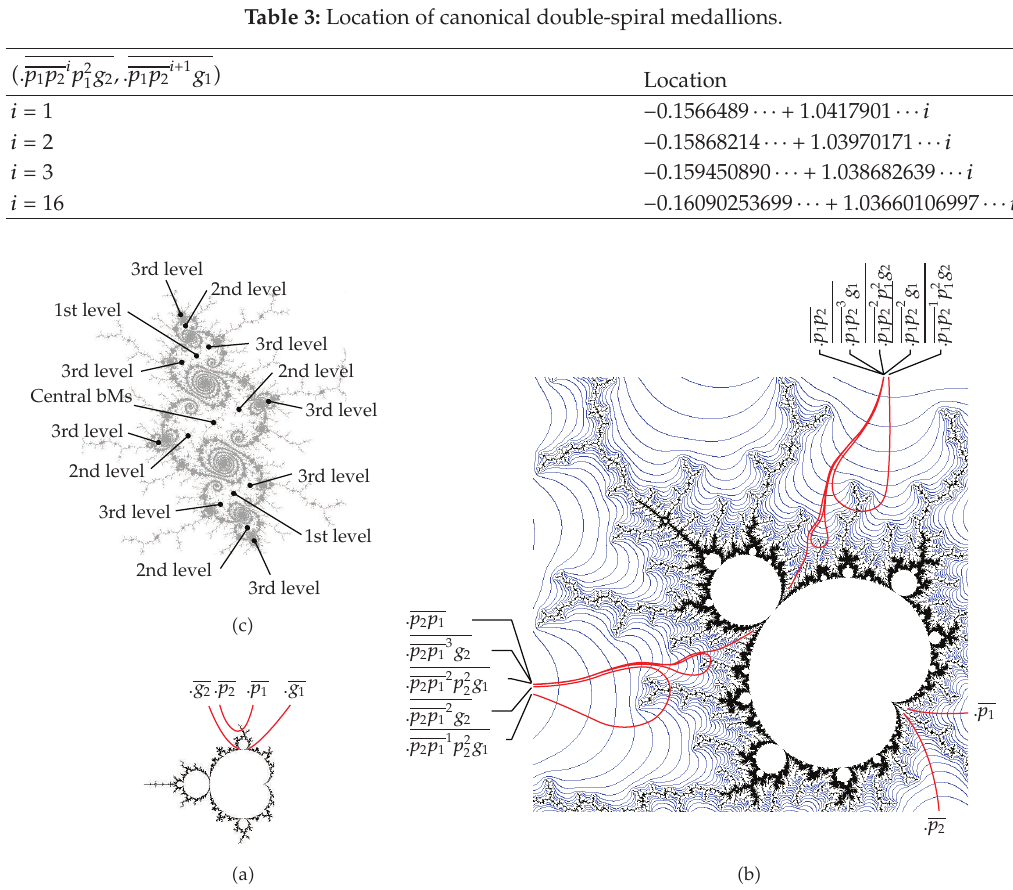
Figure 7: Canonical double-spiral medallions. (cid:4) a (cid:5) External rays of the parent and the gene. (cid:4) b (cid:5) Graphical location of the medallions i (cid:3) 1 and 2. (cid:4) c (cid:5) Detail of the medallion (cid:4) .p 1 p 216 p 2 up to third level are pointed